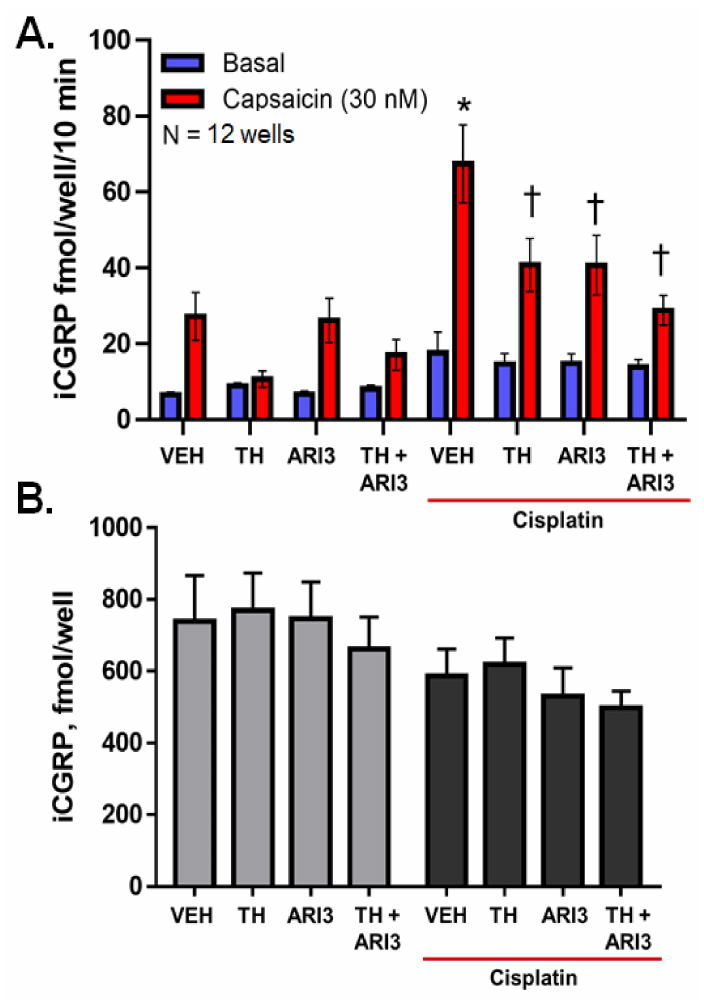
Figure 2. CGRP release from neuronal cultures is altered following exposure to cisplatin and the changes in stimulated CGRP release following exposure to base excision repair